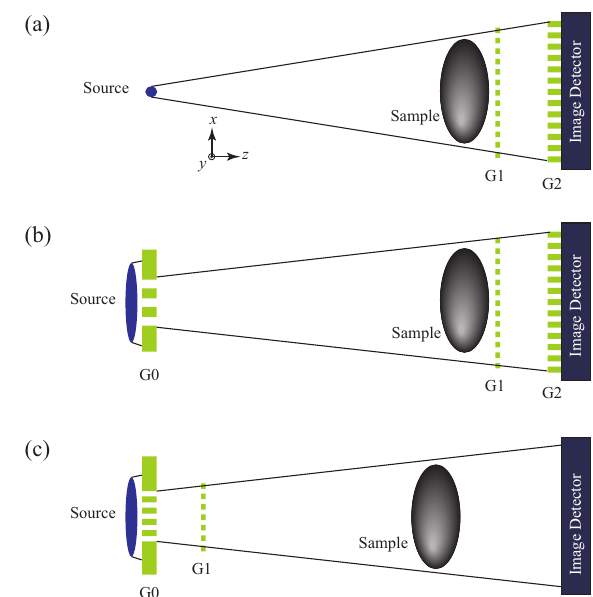
Figure 3. Configuration of grating interferometry for phase imaging: ( a ) Talbot interferometer, ( b ) Talbot–Lau interferometer, ( c ) Lau